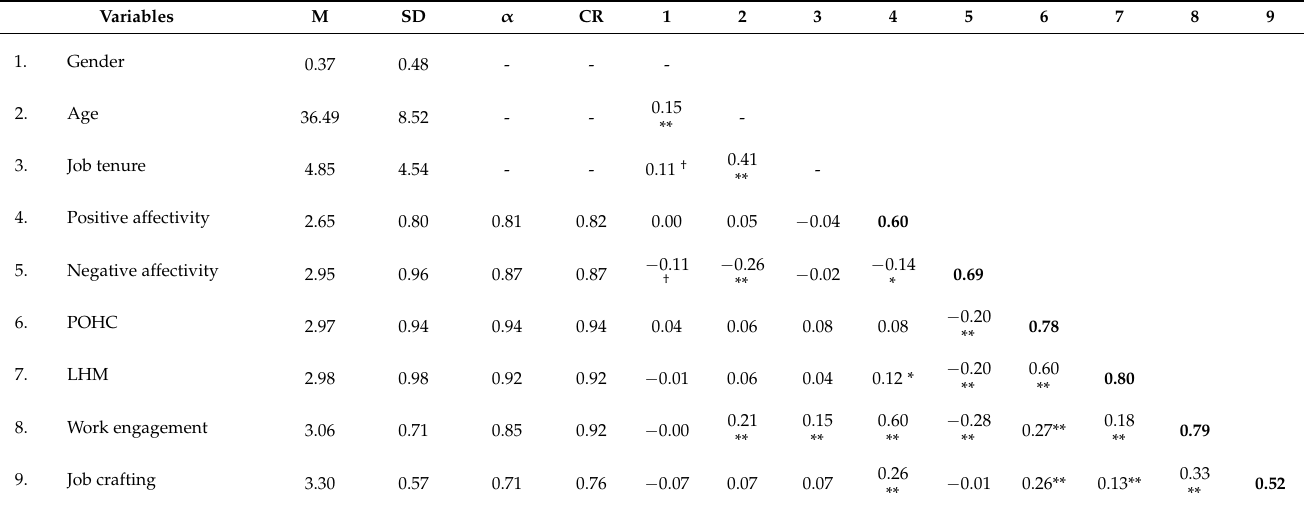
Table 2. Means, standard deviations, and correlations for the sample